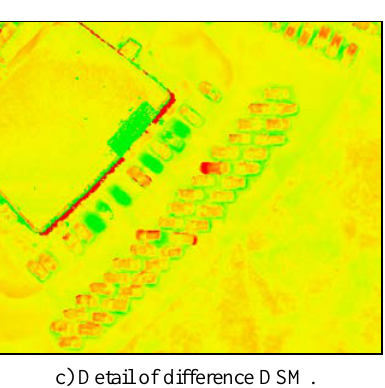
a) Detail of 140 m flight DSM.